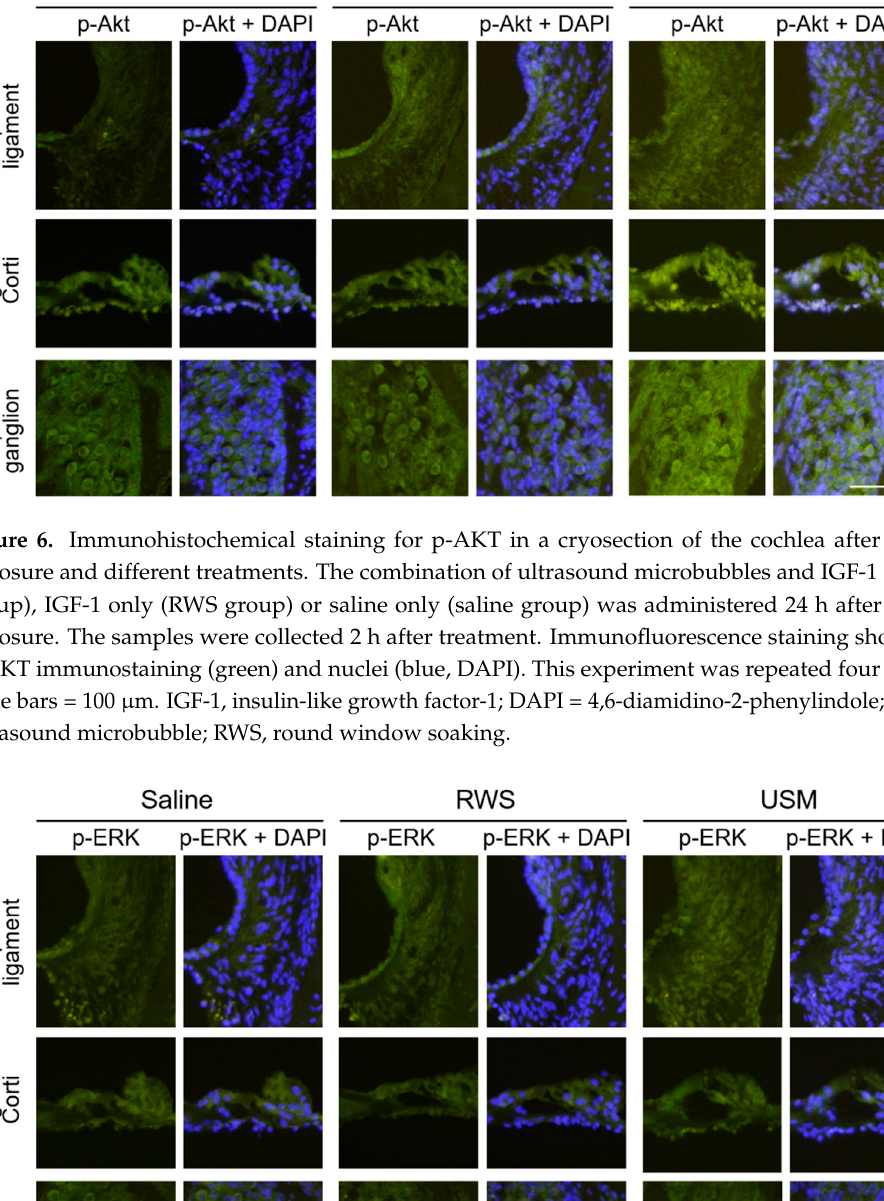
Figure 5. Ultrasound microbubble-mediated IGF-1 treatment increases the mRNA expression of Akt1 and Mapk3 in the cochlea after noise exposure. The combination of ultrasound microbubbles and IGF-1 (USM group), IGF-1 only (RWS group) or saline only (saline group) was administered 24 h after noise exposure. Total RNA was isolated from whole cochleae from the three groups 2 h after treatment. Akt1, Mapk1, and Mapk3 expression levels were quantified by quan- titative PCR. The results are expressed as the mean ± SEM; n = 9 for each bar; * p < 0.05. IGF-1, insulin-like growth factor- 1; USM, ultrasound microbubble; RWS, round window soaking.